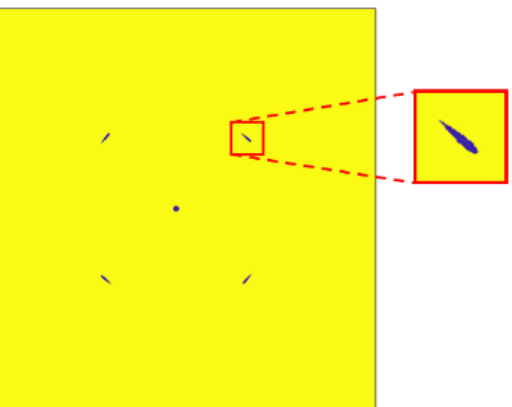
Figure 5. [0, 1] mask produced by the delineation of solid and fluid regions.